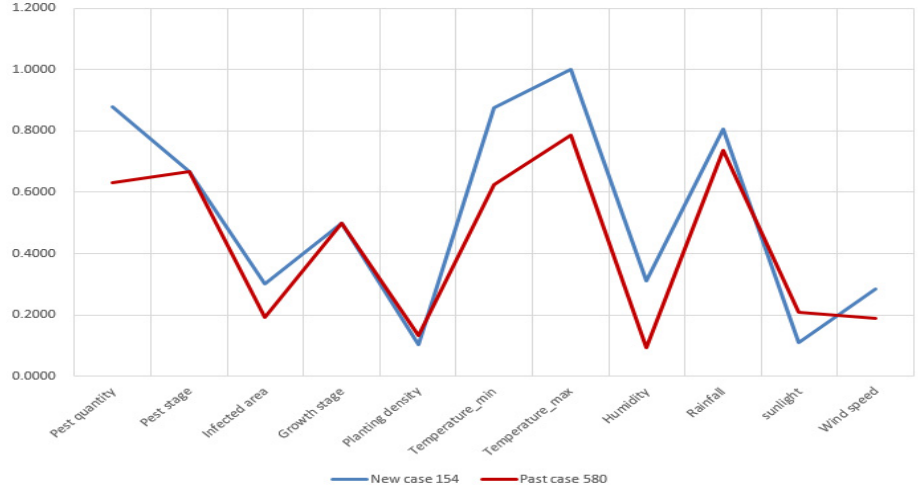
Figure A9. Attribute visualization of new case 154 and retrieved case